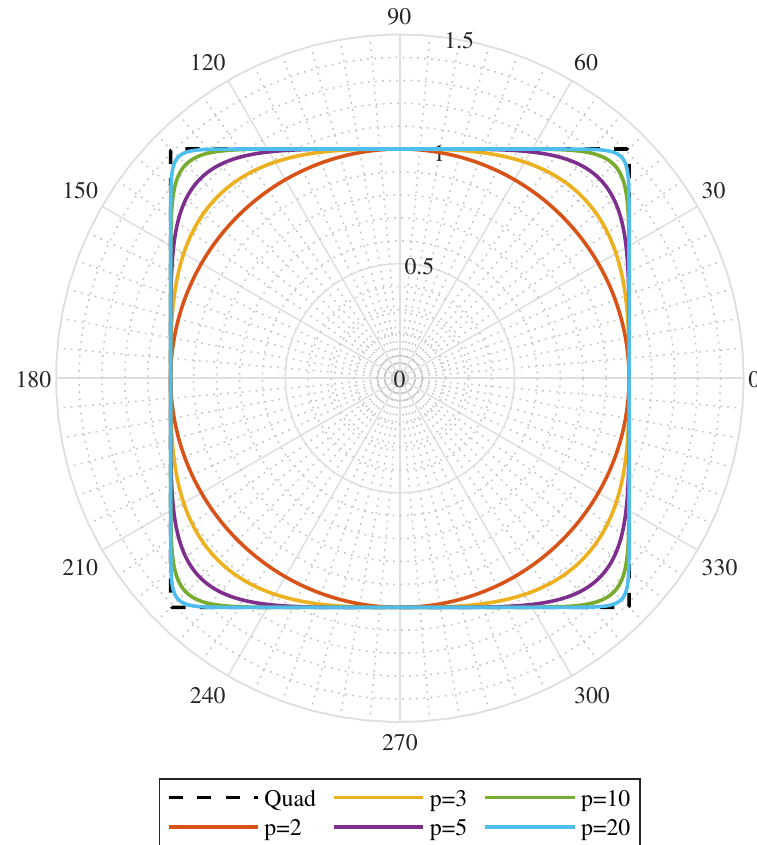
Figure 3. p -circles for different values of p . The quad denotes quadrature microstepping. Phasor length L ( φ e ) is a transcendental